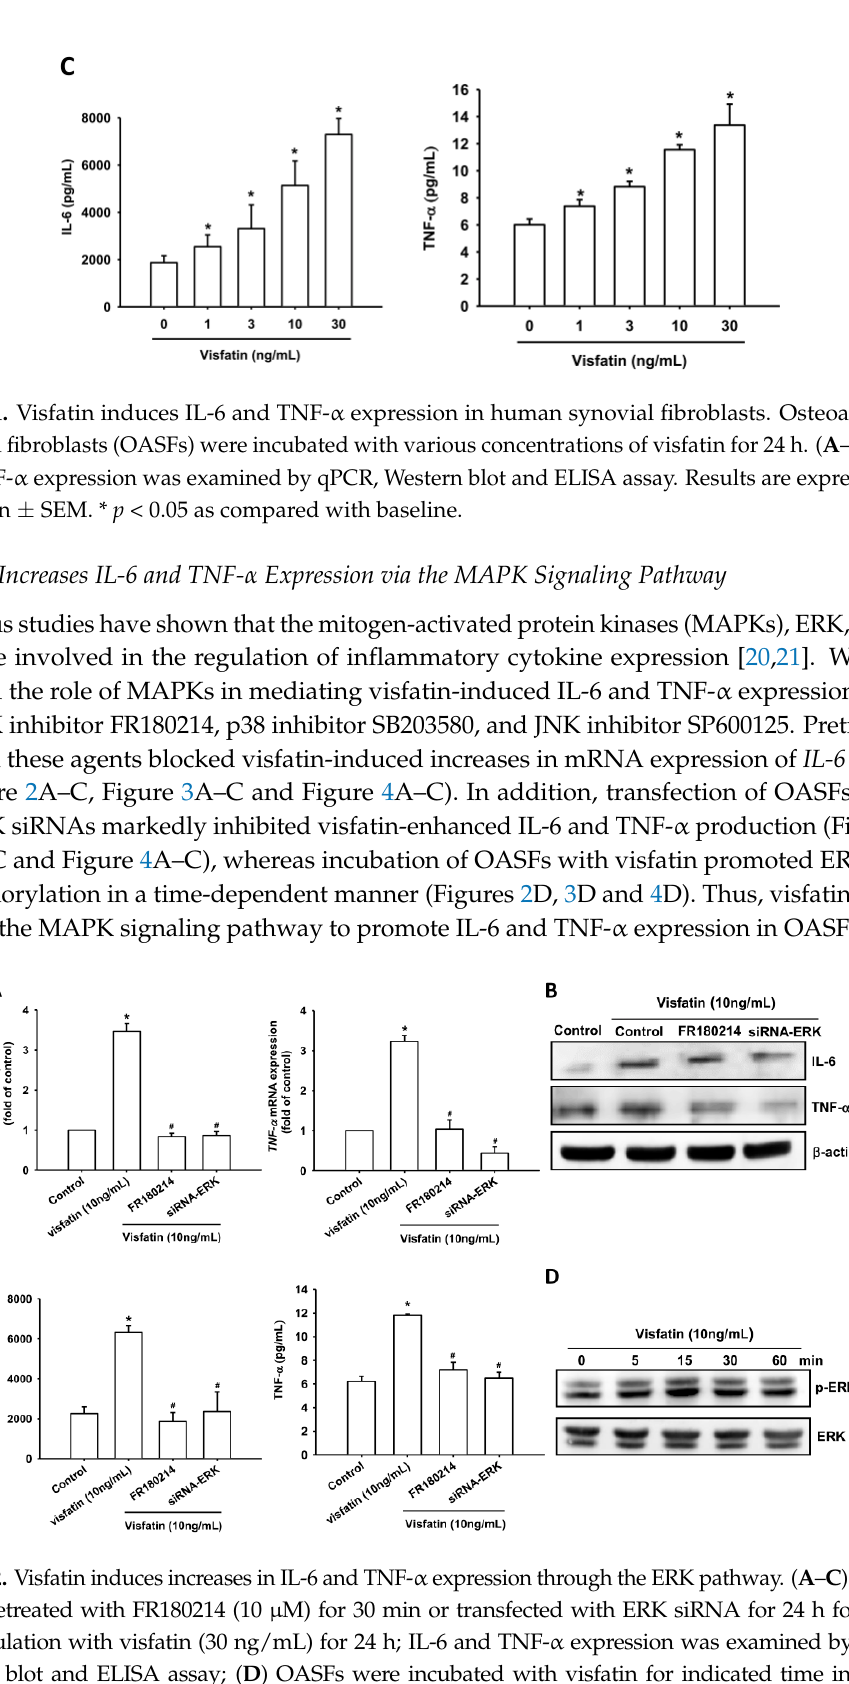
Figure 2. Visfatin induces increases in IL-6 and TNF- α expression through the ERK pathway. ( A – C ) OASFs were pretreated with FR180214 (10 μ M) for 30 min or transfected with ERK siRNA for 24 h followed by stimulation with visfatin (30 ng/mL) for 24 h; IL-6 and TNF- α expression was examined by qPCR, Western blot and ELISA assay; ( D ) OASFs were incubated with visfatin for indicated time intervals; ERK phosphorylation was examined by Western blot. Results are expressed as the mean ± SEM. * p < 0.05 as compared with baseline. # p < 0.05 as compared with the visfatin-treated group.